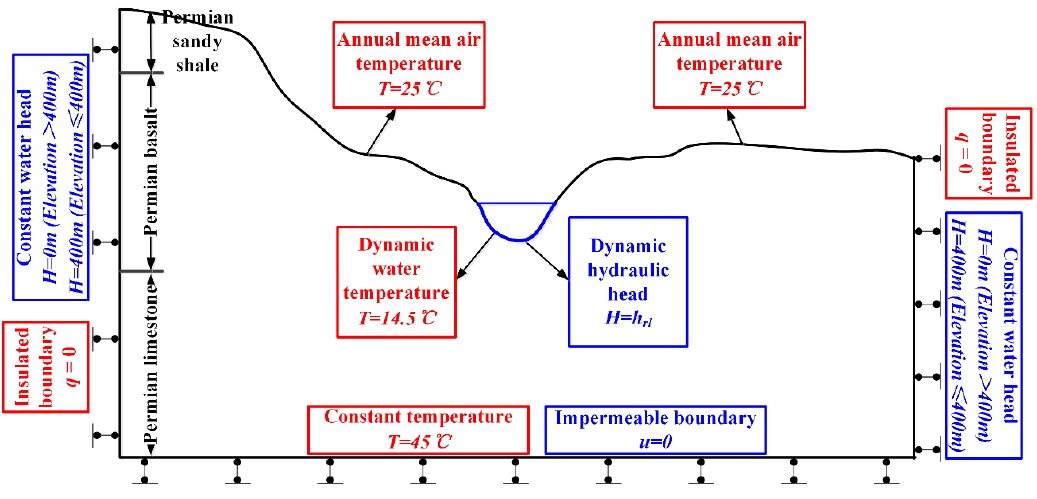
Figure 12. Boundary condition setup.